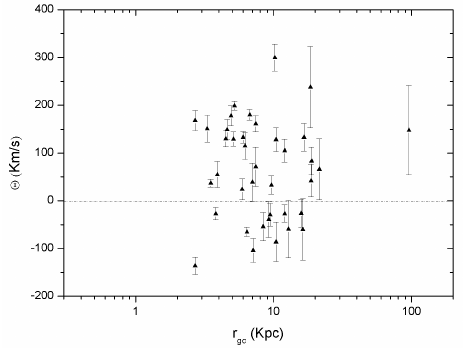
Figure 7: Motion over the Galactic plane for MW GCs (from Dinescu et al., 1999).